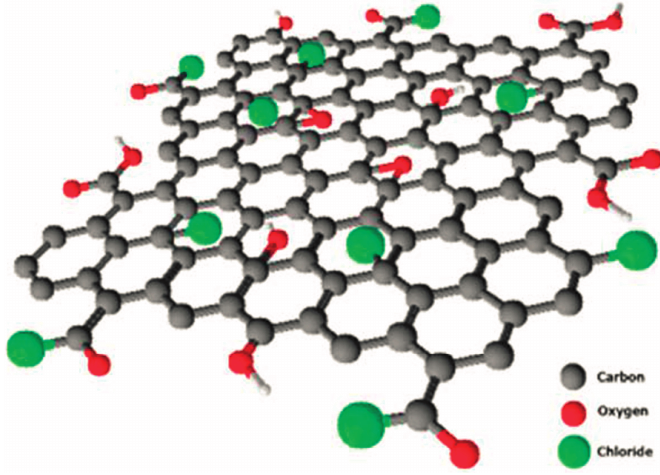
Figure 13. Chemical structure of the photo-chlorinated graphene oxide (GO–Cl) anode IFL for PSCs. Reprinted with permission from [94]. Copyright 2014 Royal Society of